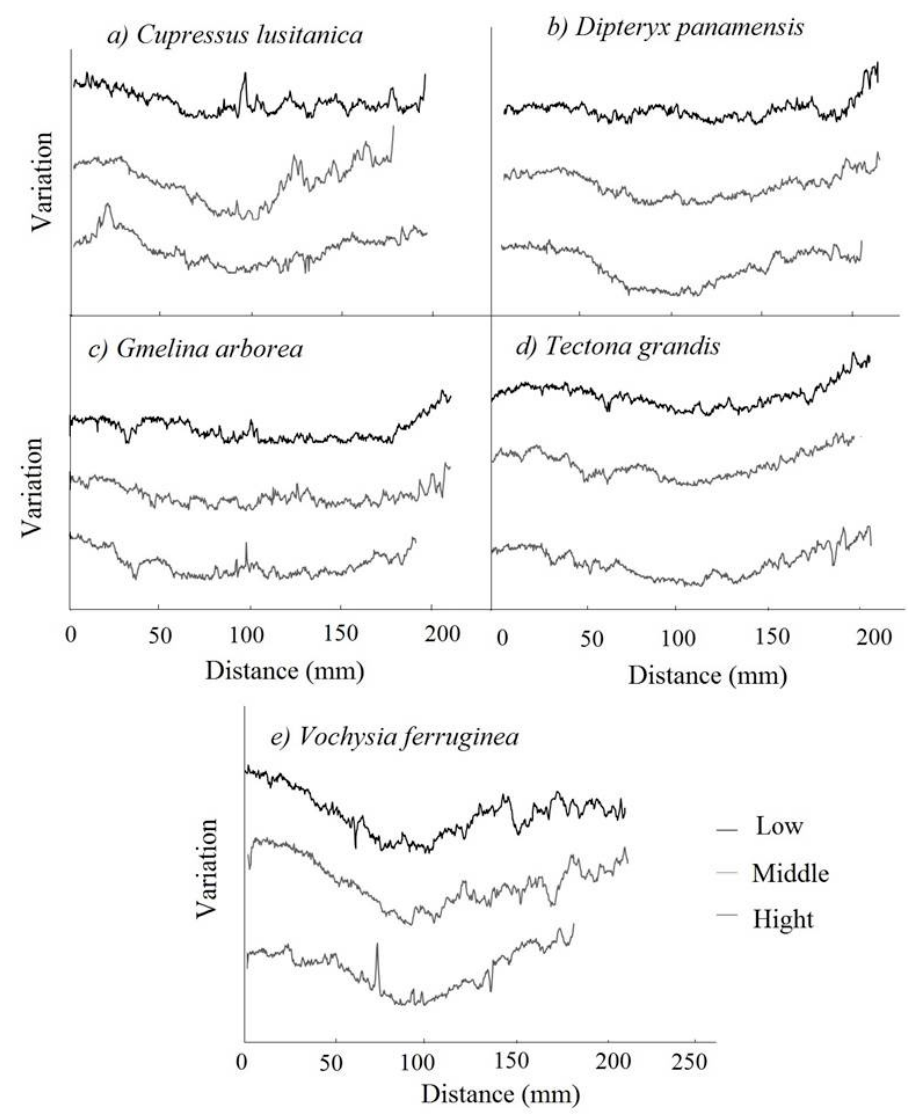
Figure 3. Density variation profiles in longitudinal direction of pellets torrefied at different temperatures and times of five types of biomass from woody tropical species: ( a ) density variation in Cupressus lusitanica ; ( b ) density variation in Dipteryx panamensis ; ( c ) density variation in Gmelina arborea ; ( d ) density variation in Tectona grandis ; ( e ) density variation in Vochysia ferruginea .